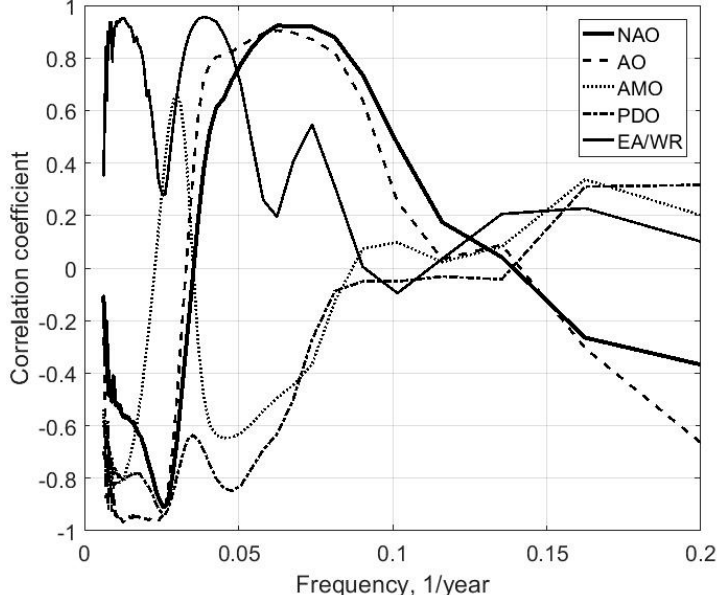
Figure 10. Coefficients of wavelet-correlation functions between the climatic indices and the power flux of wave energy at zero time lags.